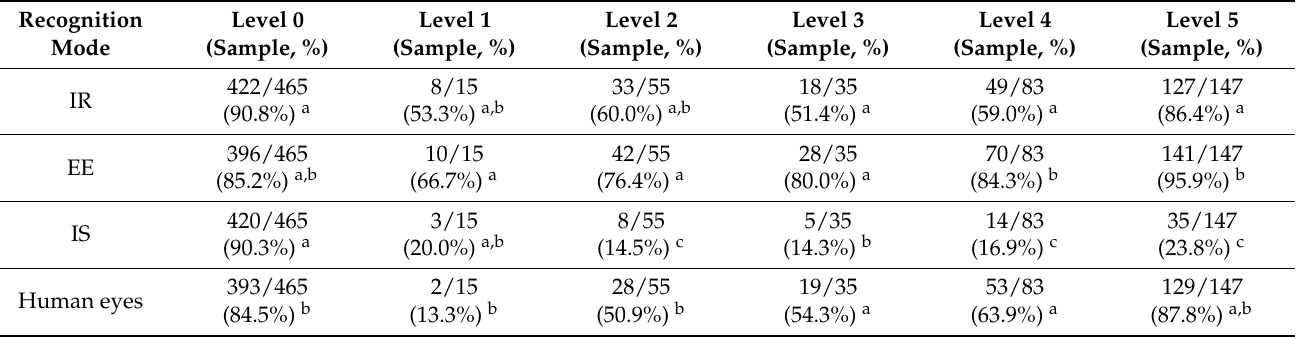
Table 3. A comparison of the performance of IR, EE, and IS recognition modes and human eyes in detecting proximal caries at different levels of severity.